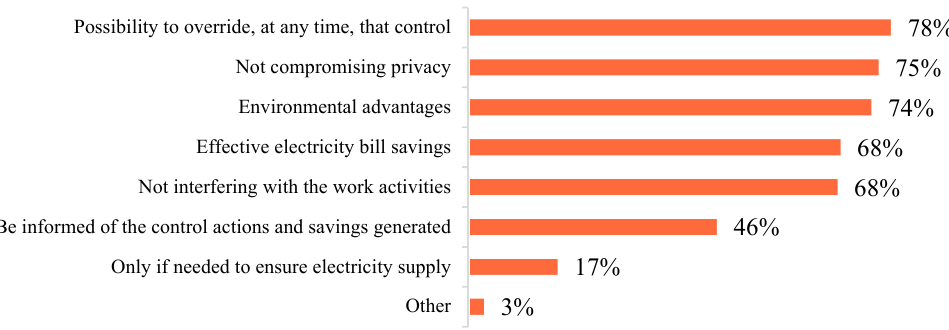
Figure 6. Conditions to accept the remote control of some appliances by the electricity utility.